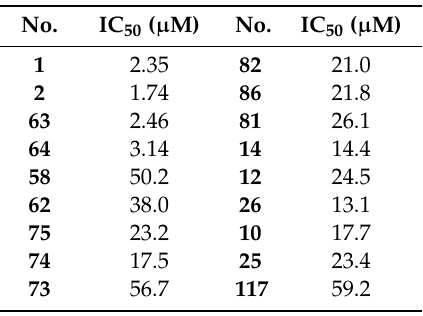
Table 9. The LPS-stimulated NO production of BV-2 microglail